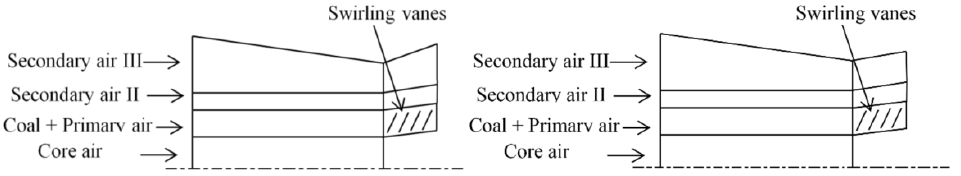
Figure 4. Scheme of the low NOx burner in 1st row on the left side and in 2nd row on the right side used in the OP 650 boiler.